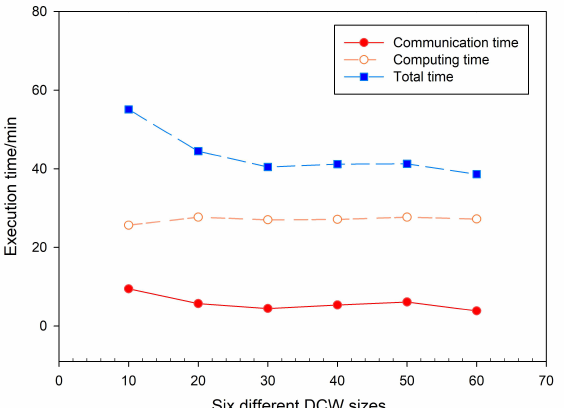
Figure 17. Comparisons of execution time using different DCW sizes.